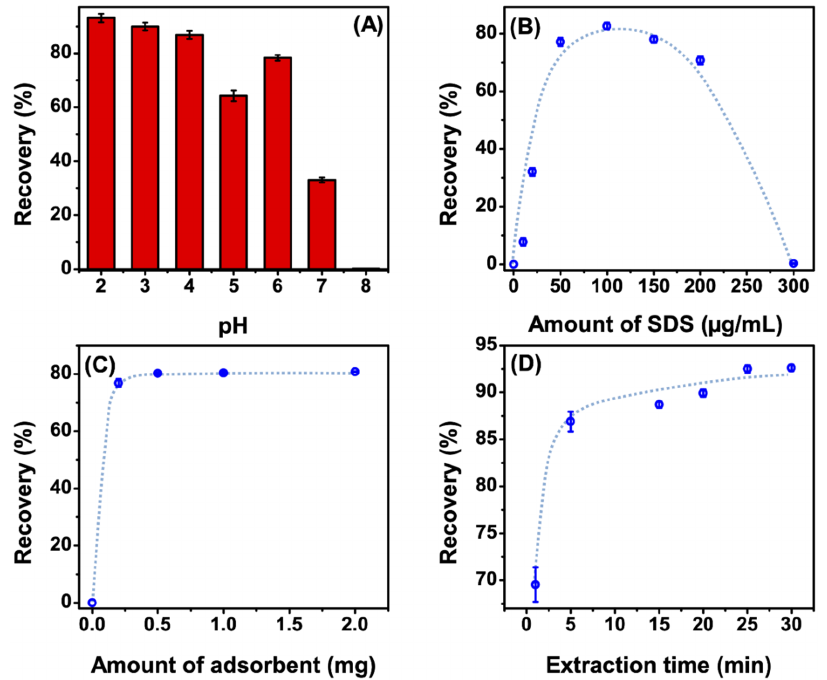
Figure 4. Effect of ( A ) pH; ( B ) the amount of sodium dodecyl sulphate (SDS); ( C ) the amount of adsorbent; and ( D ) extraction time on the extraction efficiency. Blue dashed lines are guides to the eye.